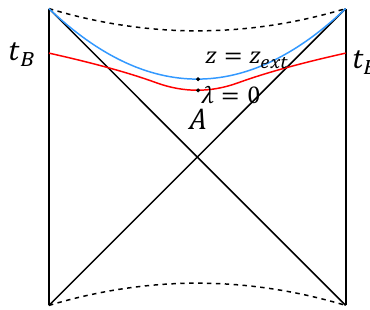
Figure 4 . The red curve is the extremal surface, the blue curve is the extremal surface with z A = z ext . With the time t B goes to infinite, the extremal surface will be infinitely approach to the blue